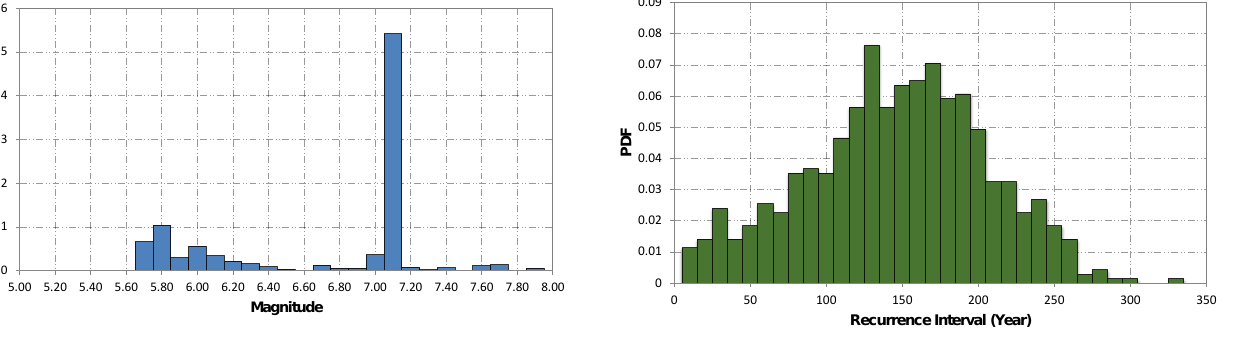
Fig. 7. Probability distribution function (PDF) of recurrence in- tervals for earthquakes with M > 6.5 on the Hayward Fault during the 100000yr simulation. The mean recurrence time is 141yr with C v = 0.42. The bin width is